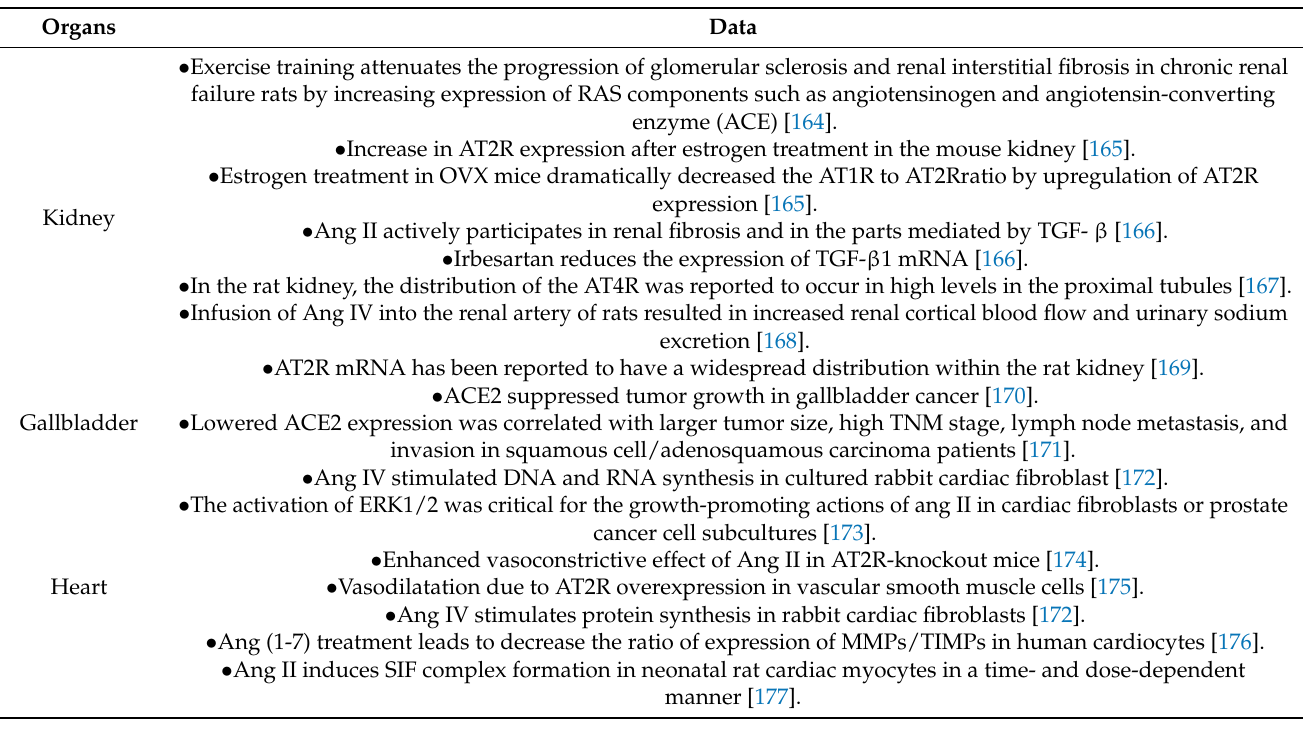
Table 1. Other organs/medical conditions and potential influence of renin-angiotensin system (RAS) on their function and/or